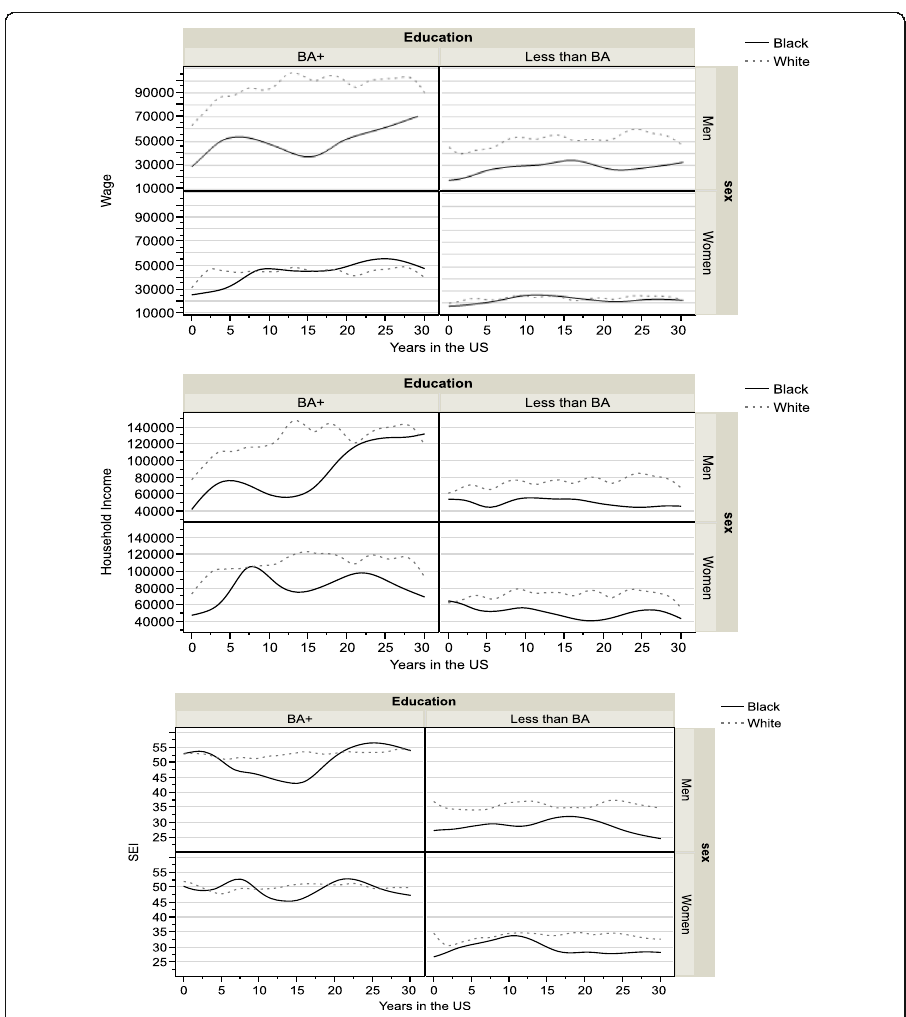
Fig. 2 Graphs of economic advancement over the years: immigrant blacks vs. immigrant whites, age 25 to